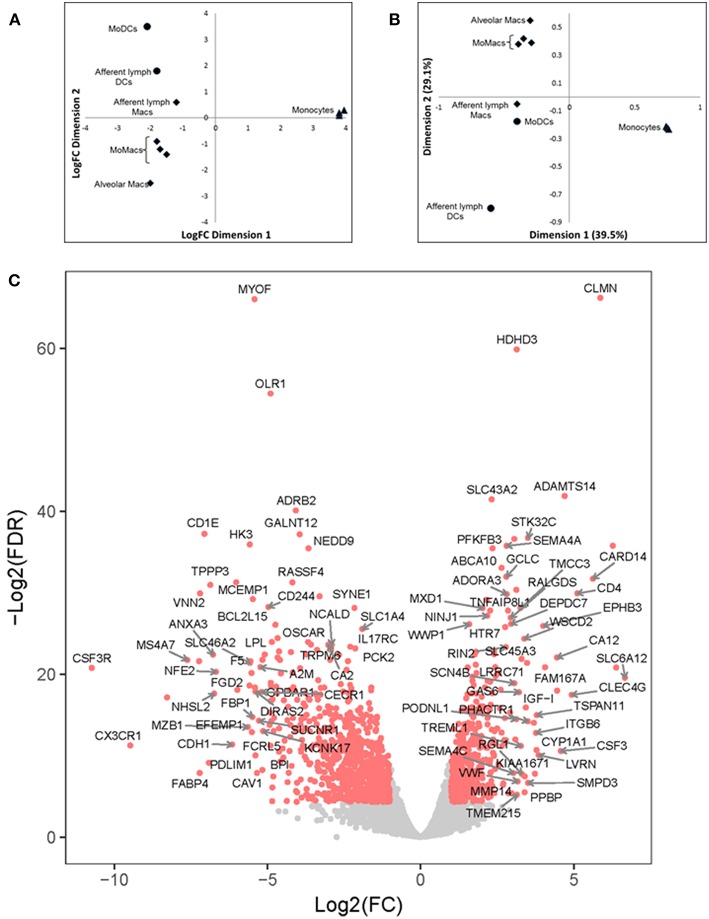
Differentially-expressed (DE) genes in bovine blood monocytes, Macs and DCs obtained from the afferent lymph and those obtained in vitro from monocyte progenitors. Bovine blood monocytes (CD14+, triangles), Macs (diamonds), and DCs (circles, N = 4, as defined in Figure 1) were flow sorted and total RNA extracted. RNA sequencing was performed on a NextSeq 500 system and DE analysis was performed as described and Materials and Methods. (A) Multi-Dimensional Scaling (MDS) analysis on leading log fold-change (500 most expressed genes) as performed by edgeR on samples. (B) Bi-plot of Correspondence Analysis (CA) on samples (no genes drawn). In both cases the circles represent DCs, diamonds represent Macs and triangles represent blood monocytes. (C) Volcano plot showing differential expression (LogFC) vs. statistical significance (LogFD) of grouped DCs vs. Macs. Red dots represent differentially expressed (p < 0.001). The 20 genes giving the largest contribution to inertia are listed in Table 3.